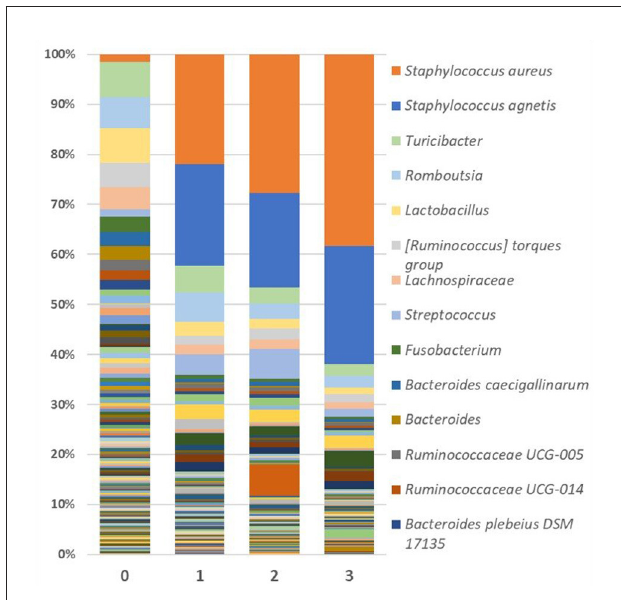
FIGURE5 Relative abundance as average percentage of bacterial taxa populations for skin samples grouped by lesion score. The predominant S taphylococcus aureus OTU was present at 0.709, 2.063, 21.647, and 37.787% for lesion scores 0, 1, 2, and 3, respectively. Staphylococcus agnetis was present at 0.043, 19.969, 18.564, and 23.125% for lesion scores 0, 1, 2, and 3, respectively.